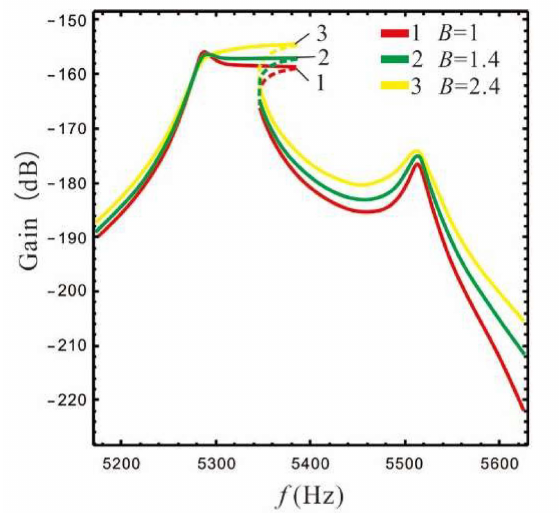
Figure 14. Gain is affected by the LR: (cid:101) 1 = (cid:101) ep ( B = 1.4, (cid:101) ep = 0.93; B = 2.4, (cid:101) ep = 0.95 ) .